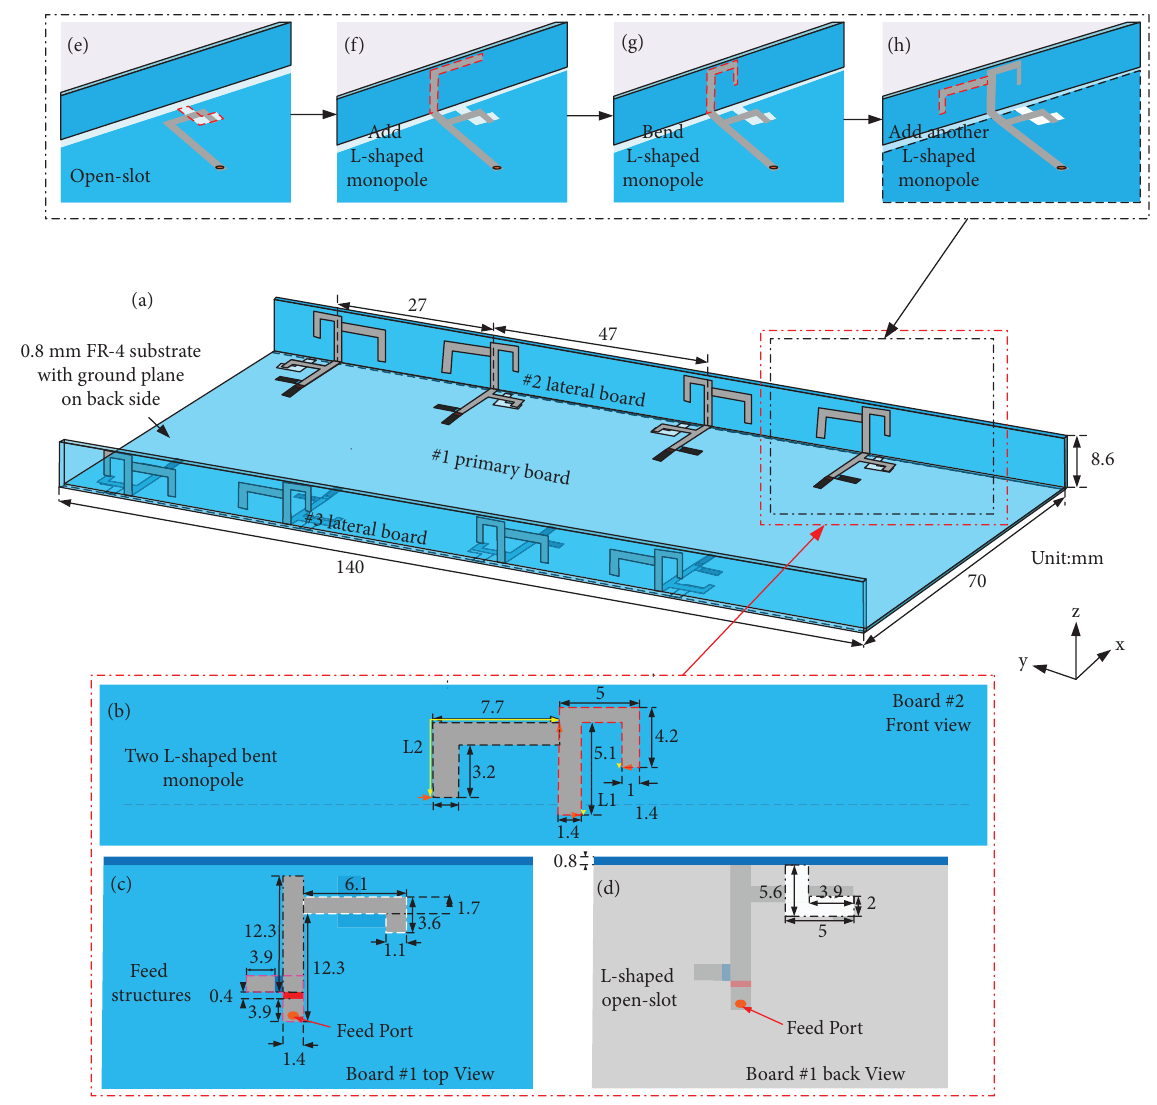
Figure 1: Confguration and design procedure of the antenna